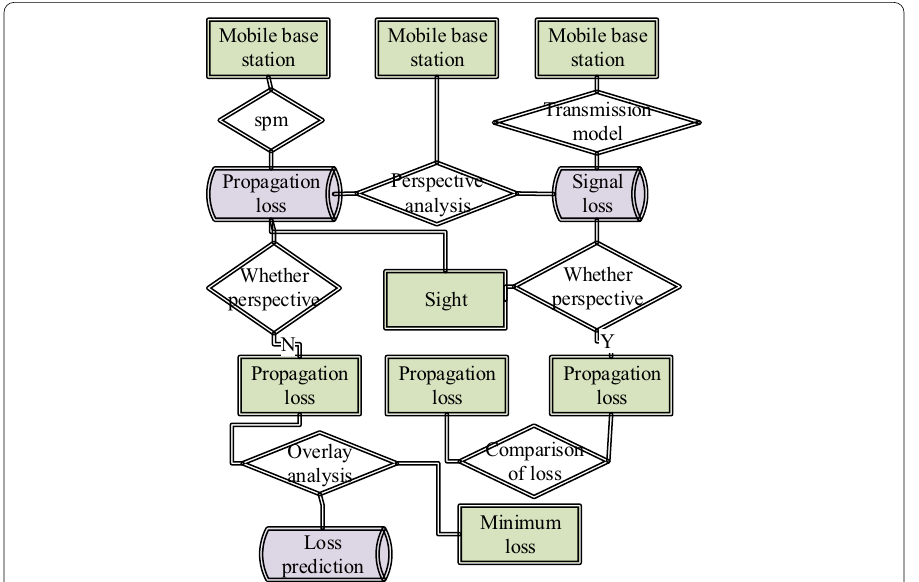
Fig. 1 Visual simulation flow of wireless communication network propagation loss